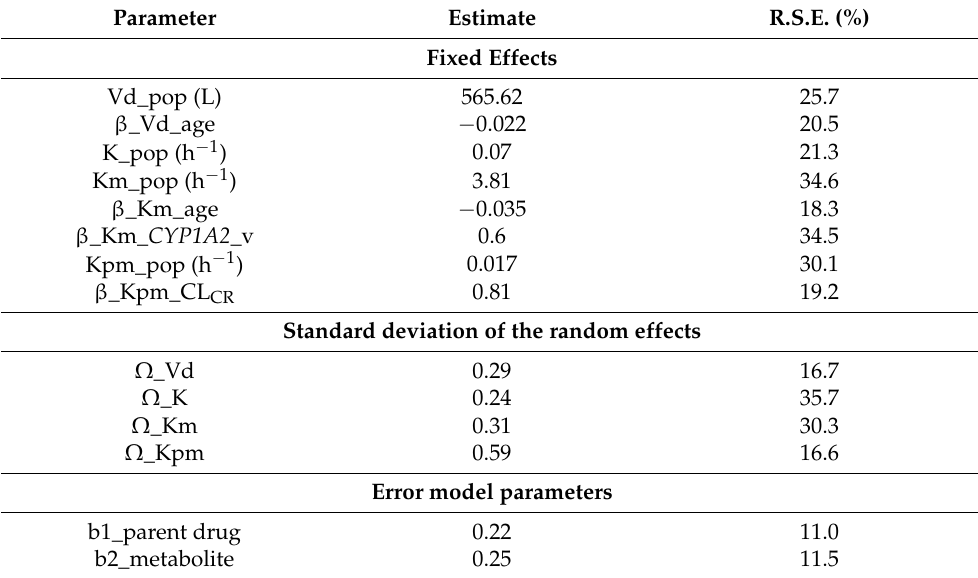
Table 4. Estimates of the final ciprofloxacin–desethylene ciprofloxacin population pharmacoki- netic